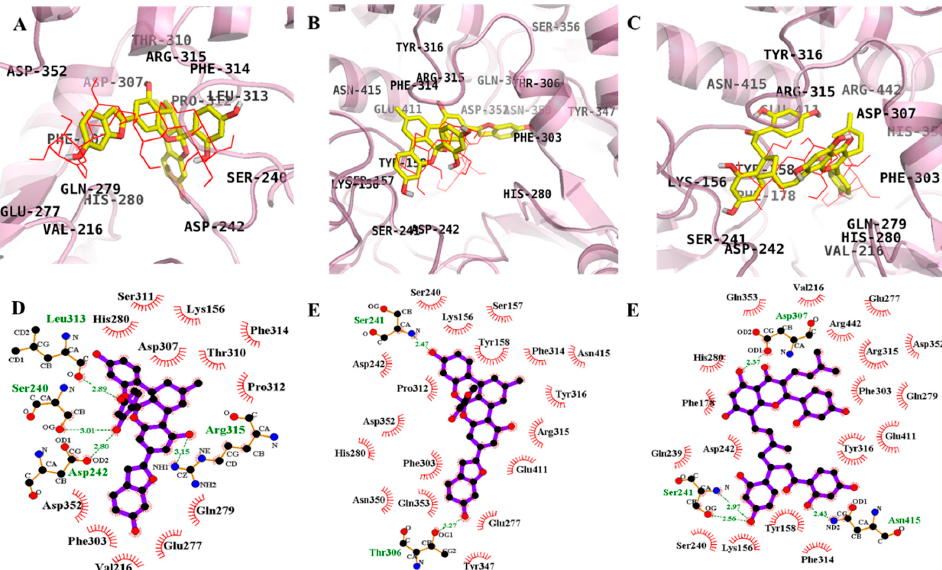
Figure 5. Molecular docking models for α -glucosidase inhibition at catalytic site by compounds 1 – 3 along with reported inhibitor acarbose (red line). 1 ( A ); 2 ( B ); and 3 ( C ). 2D ligand interaction diagram of α -glucosidase inhibition by 1 ( D ); 2 ( E ); and 3 ( F ). Schematic representation of interaction between ligands 1 – 3 and the α -glucosidase, thick purple stick models present the compounds 1 – 3 , green dotted lines are hydrogen bonds, and dashed half-moons present hydrophobic interactions with corresponding amino acid residues of the enzyme. Table 3. Molecular interaction of the α -glucosidase active site with 1 – 3 as well as reported inhibitors. Compound Binding Energy a (kcal/mol) No. of H-Bond b H-Bond Interacting Residues c